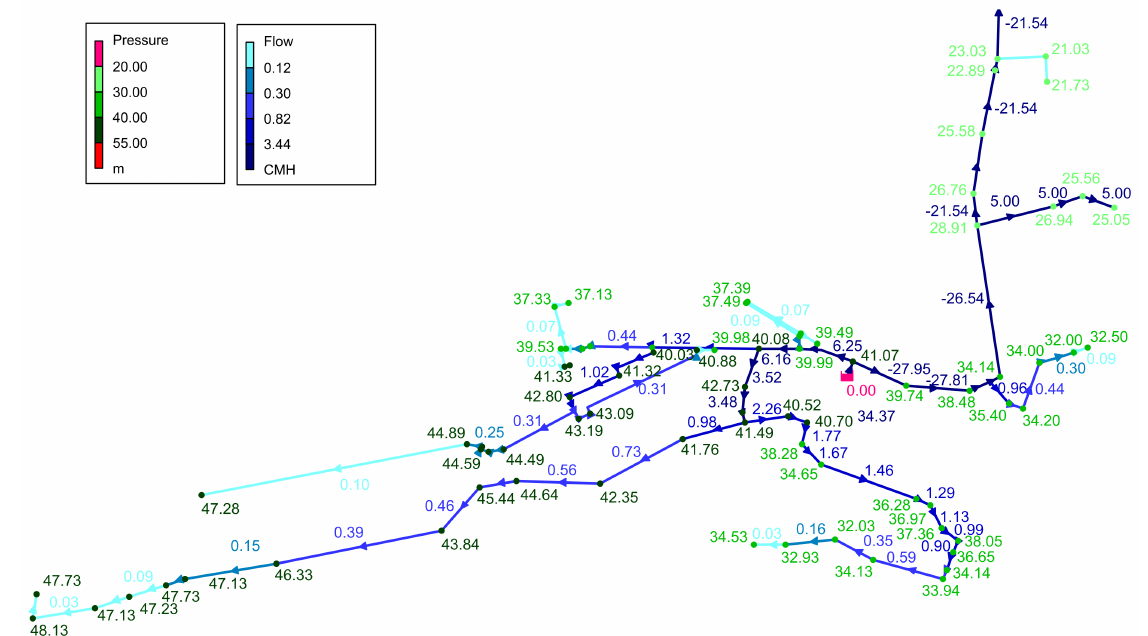
Figure 5. The pressure and flow rate for the average hourly water demand; zoomed view of the map on the southern part of the network together with the intake.